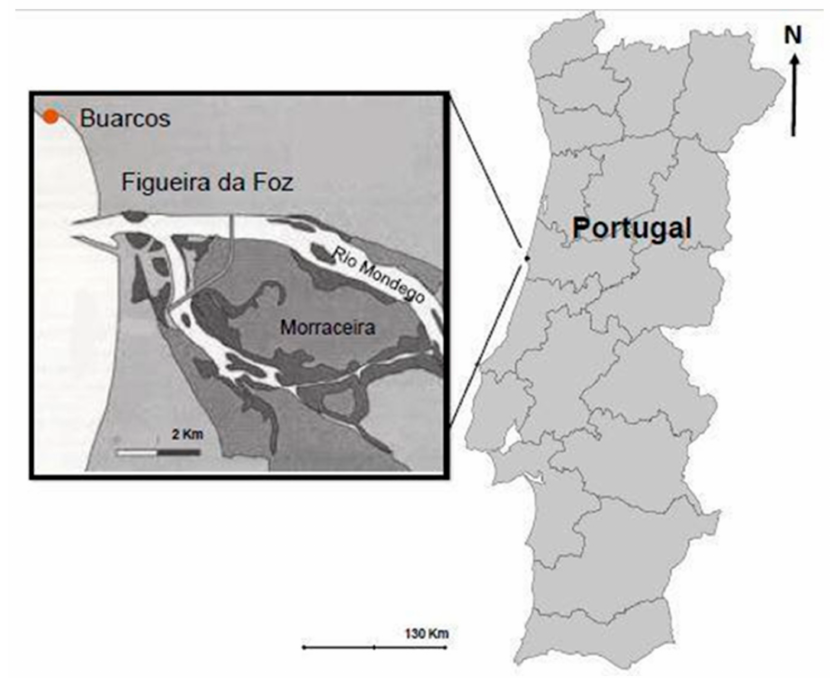
Figure 2. Sampling site: Morraceira Island (41 ◦ 57 (cid:48) 56 (cid:48)(cid:48) N, 8 ◦ 44 (cid:48) 30 (cid:48)(cid:48) W), Figueira da Foz,